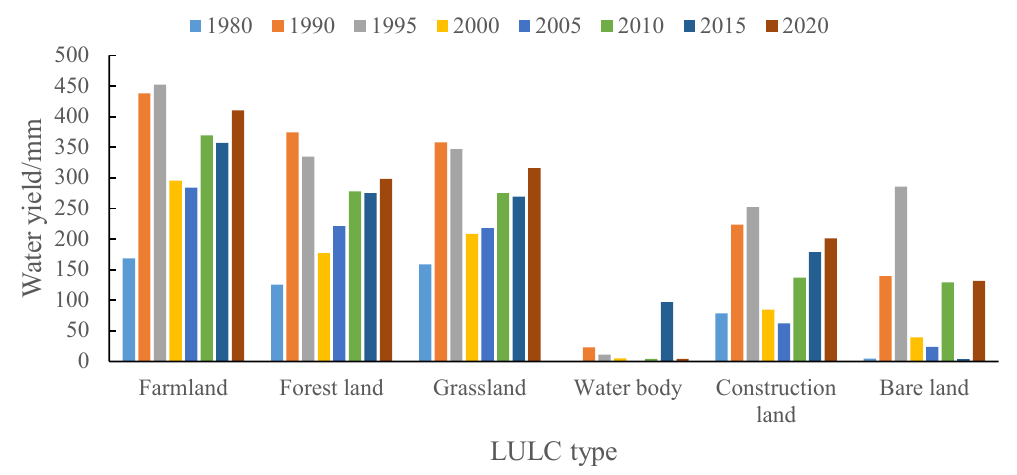
Figure 8. Water yield of different land use/land cover in the eight years during 1980–2020. We converted the depth of water yield into the volume of water yield to show that the volumetric water yield of the mountainous area in BTH was at a maximum in 1990, at 4.61 × 10 10 m 3 , followed by 4.45 × 10 10 m 3 in 1995 (Figure 9). The volumetric water yield after 2000 was lower than that of 1990 and 1995, but showed an increasing trend. The volumetric water yield in 2020 was 3.95 × 10 10 m 3 , increasing by 1.84 × 10 10 m 3 in 1980 and 2.65 × 10 10 m 3 in 2000. The trends in the proportion of volumetric water yield for forest land, grassland, and farmland also differed from the depth of water yield. Although the depth of water yield was highest in farmland in 1995, the proportion of volumetric water yield was the largest in forest land, at 40.65%. At the same time, comparing the proportion of volumetric water yield of forest land, grassland, and farmland in 1980, 2000, and 2020, it can be seen that although the proportion of volumetric water yield of farmland was still the highest in 2020, at 38.15%, which was greater than 31.32% in 1980, but lower than 44.45% in 2000. The proportion of volumetric water yield of grassland decreased even more, from 50.24% in 1980 to 26.43% in 2000 and 25.95% in 2020, respectively. The proportion of volumetric water yield of forest land, on the other hand, showed an increasing trend, from 17.93% in 1980 to 27.89% in 2000 and 32.04% in 2020. As for the other three LULC types, the proportions of volumetric water yield were below 5% or less, and they did not change much over the study period.